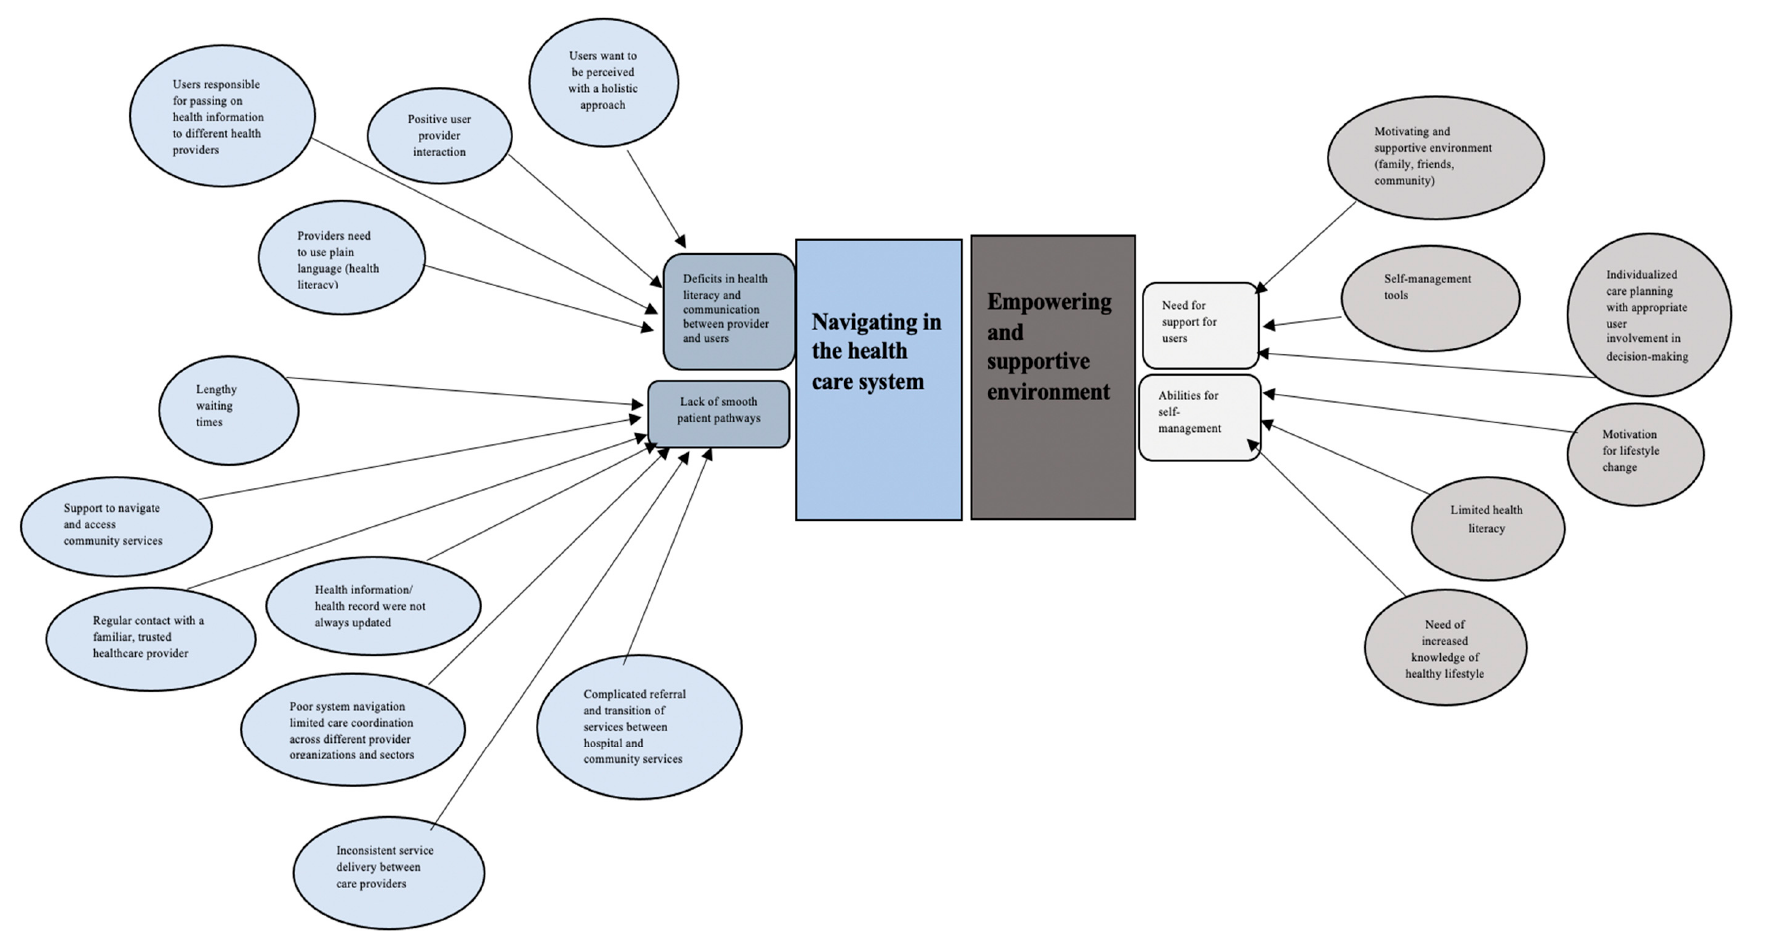
Figure 3. Concept map of users’ perception about integrated care.